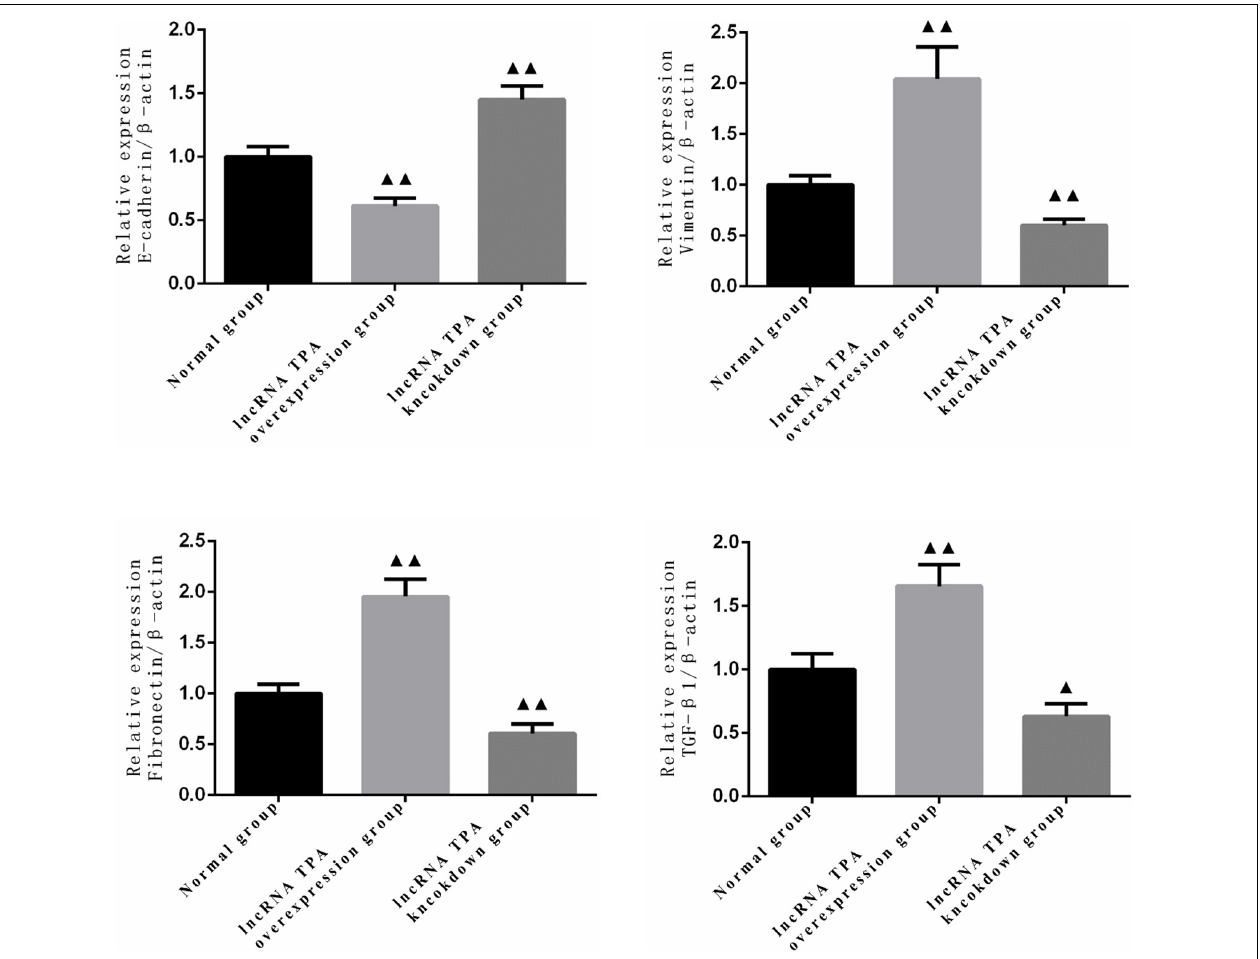
FIGURE 2 | Statistics of protein expression levels of E-cadherin, Vimentin, fibronectin and TGF- β 1 in lncRNA TPA overexpression and knockdown stably transfected breast cancer cell lines (x ± s, n = 3). (cid:78)(cid:78) Indicating p < 0.01 compared with the control group, (cid:78) Indicating p < 0.05 compared with the control